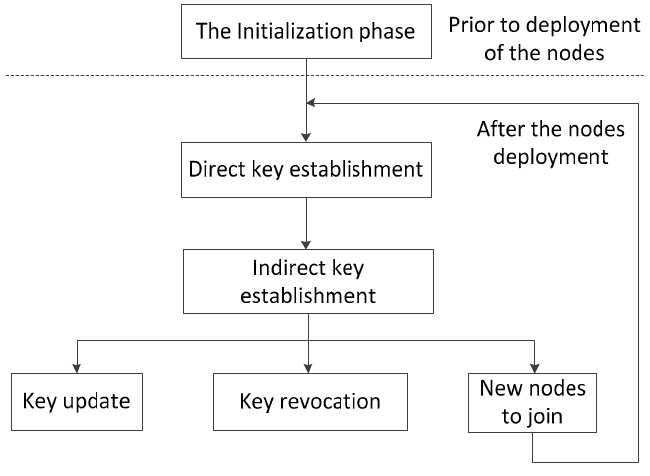
Figure 2. The main process of the PPBR scheme.